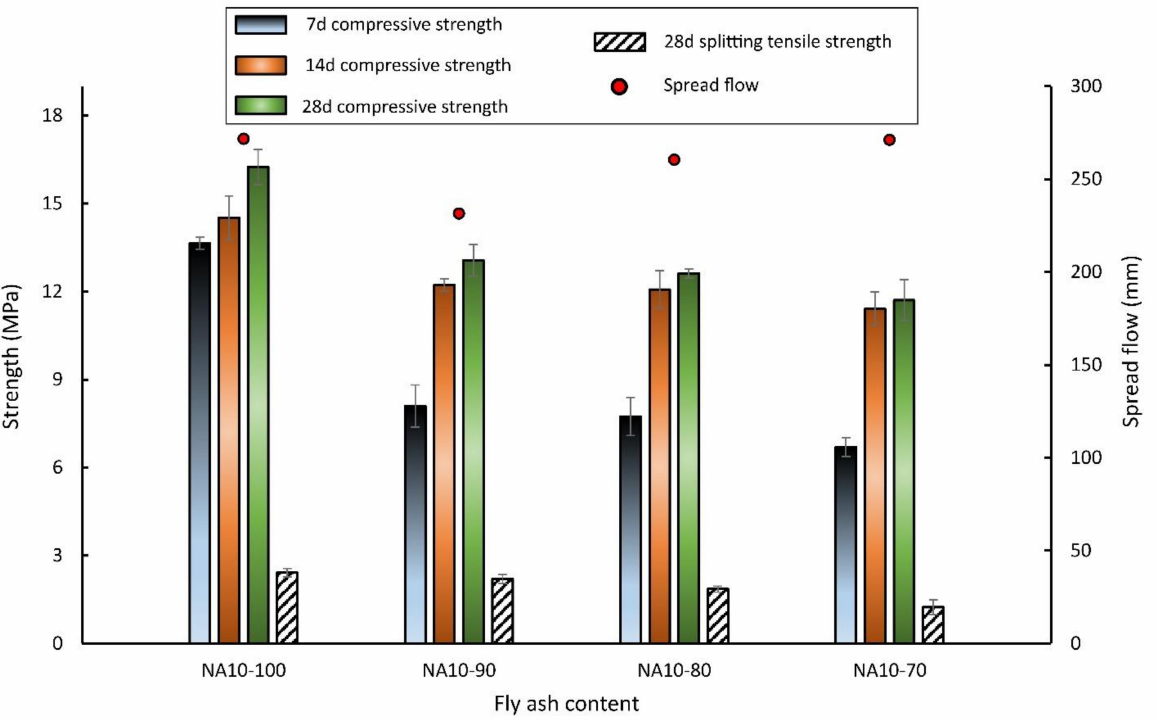
Figure 9. Flow spread and compressive and splitting tensile strengths of mortar when replacing the binder with fly ash (0–30%) in the presence of the optimum concentration of nano-Al 2 O 3 particles